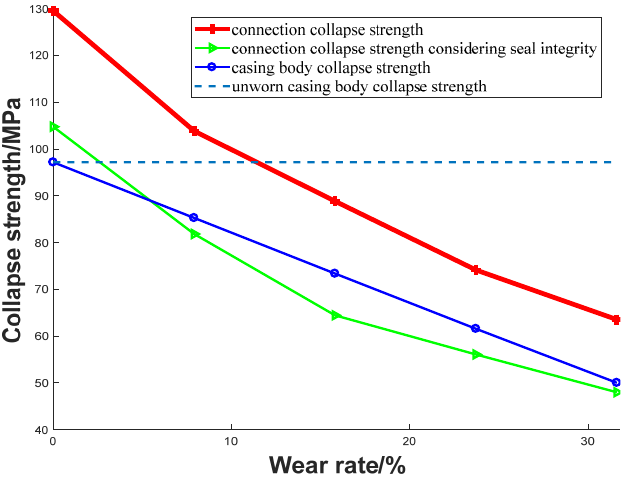
Figure 14. Collapse strength of casing body and connection under different wear depths.